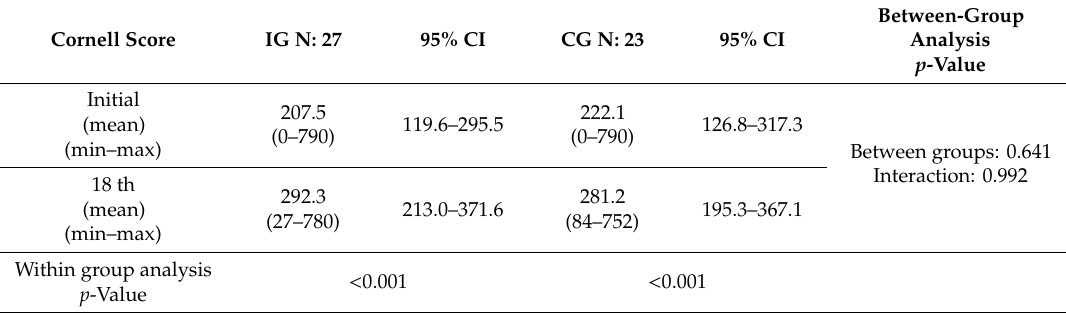
Table 6. Two-factor repeated measures ANOVA